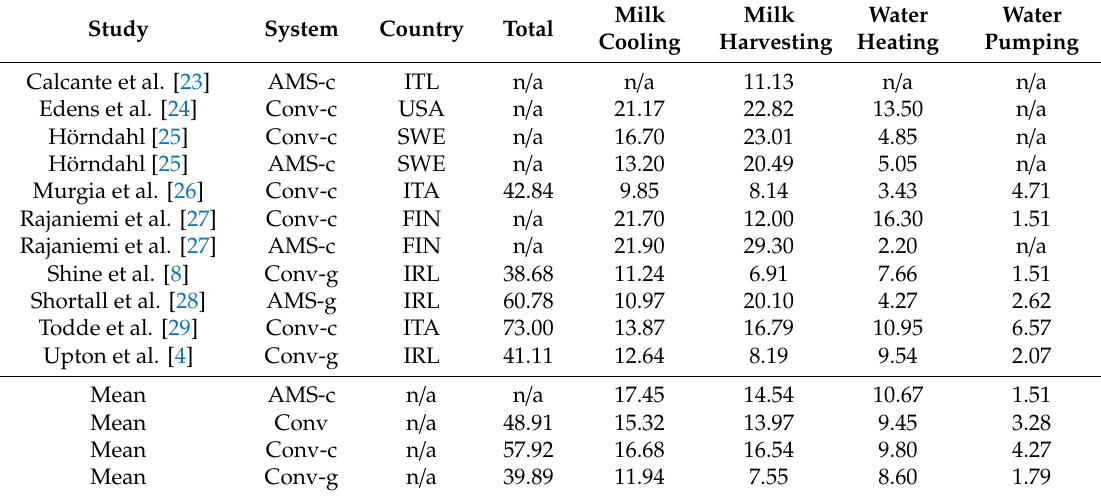
Table 4. Electrical energy consumption breakdown statistics of studies found in literature (Wh kg − 1